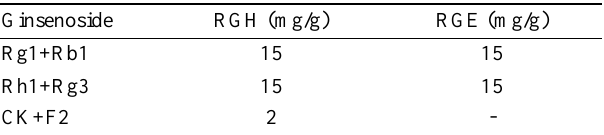
Table 1. Contents of ginsenosides in red ginseng hydrolyzates (RGH) and red ginseng extracts (RGE)